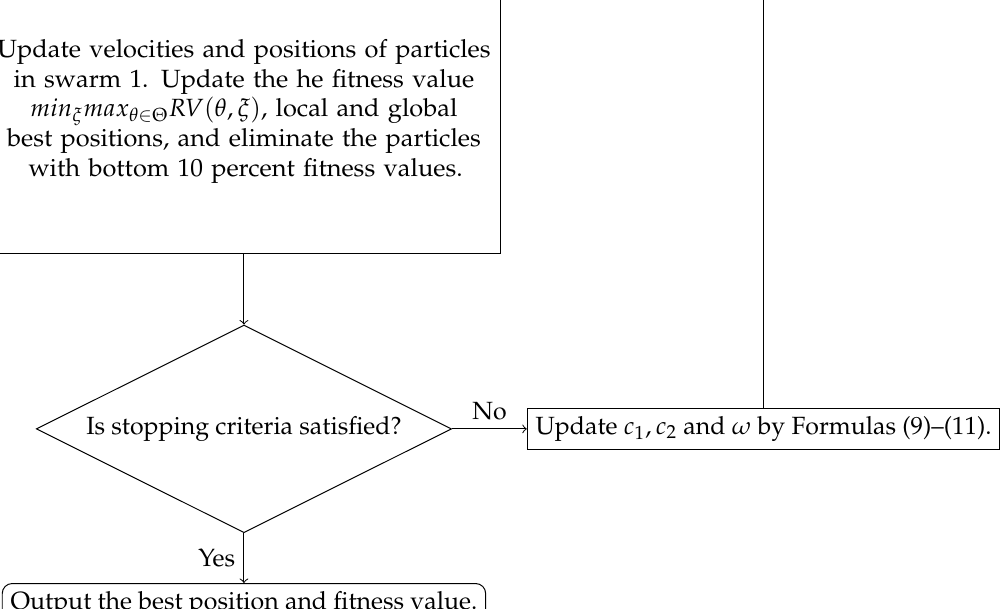
Figure A3. Flowchart of Algorithm